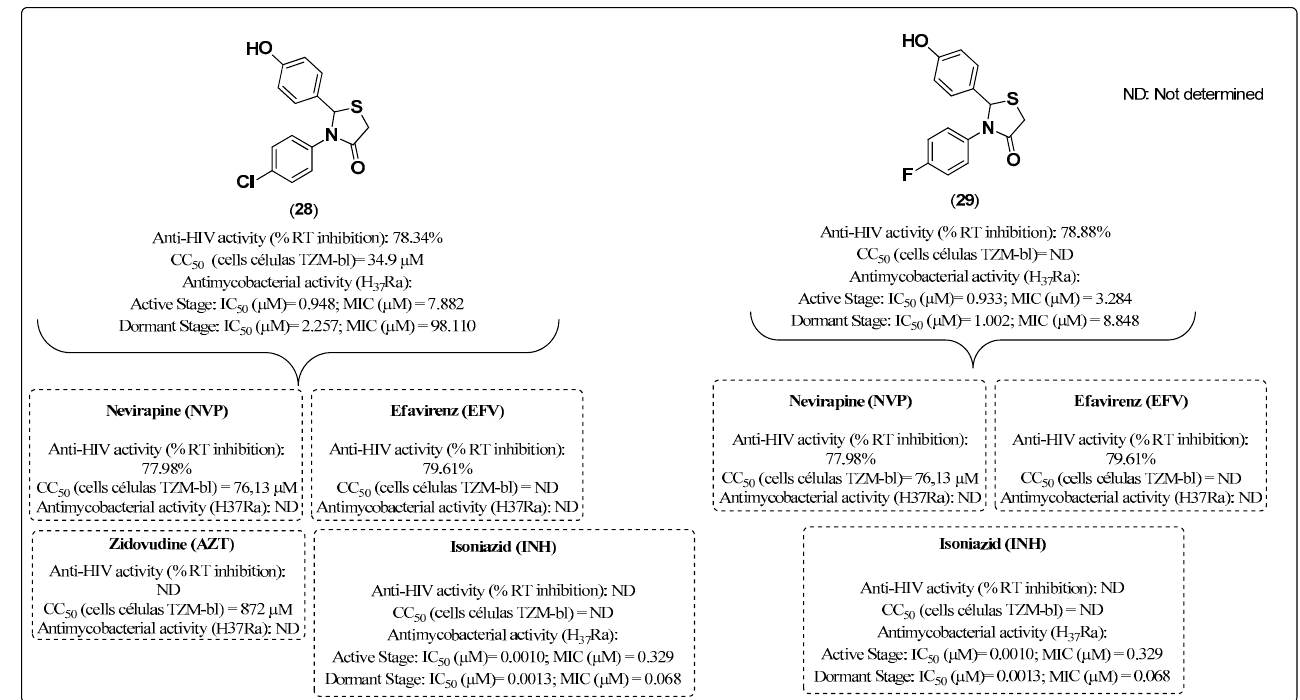
Figure 22. Compounds 28 and 29 and their anti-HIV and anti-MTB activities reported by Chitre and collaborators in 2009 [113].